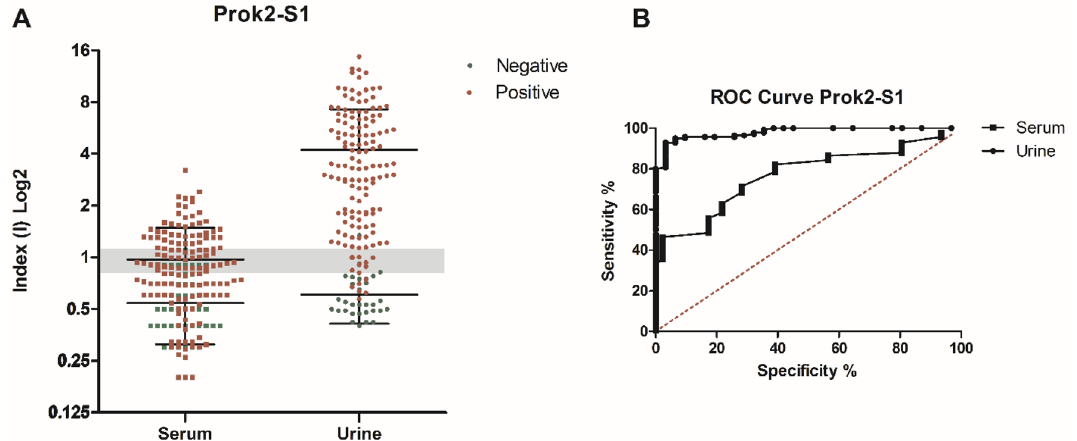
Figure 5. Comparative diagnostic performance of rSARS-CoV-2 Prok2-S1 protein with patient urine and serum samples. ( A ) ELISA assays were done using positive samples (n = 140 urine and n = 140 serum) from COVID-19 patients with previously positive qRT-PCR and negative samples (n = 31 urine and n = 46 serum). The mean of each group is shown and the gray band indicates indeterminate values for each sample, while index values below the range (< 0.8) are negative and values above (> 1.1) are considered positive. ( B ) Receiver Operating Characteristic (ROC) curves were constructed using the individual index (I) value for each sample, to obtain sensitivity, specificity and area under the curve